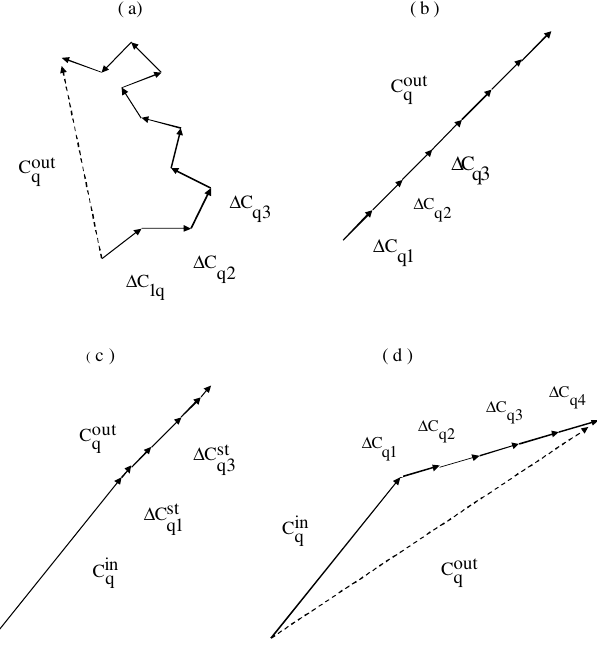
FIG. 6. Schematic description of the four radiative emission processes in the complex plane of the mode amplitude C out which is composed of C in radiation wave packets (cid:7) C (b) superradiance, (c) stimulated emission, and (d) stimulated